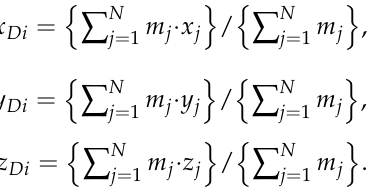
Table 5. Magnitudes and signs of the chirality obtained for L-FF and D-FF PNTs for various calculating methods. Type of PNT